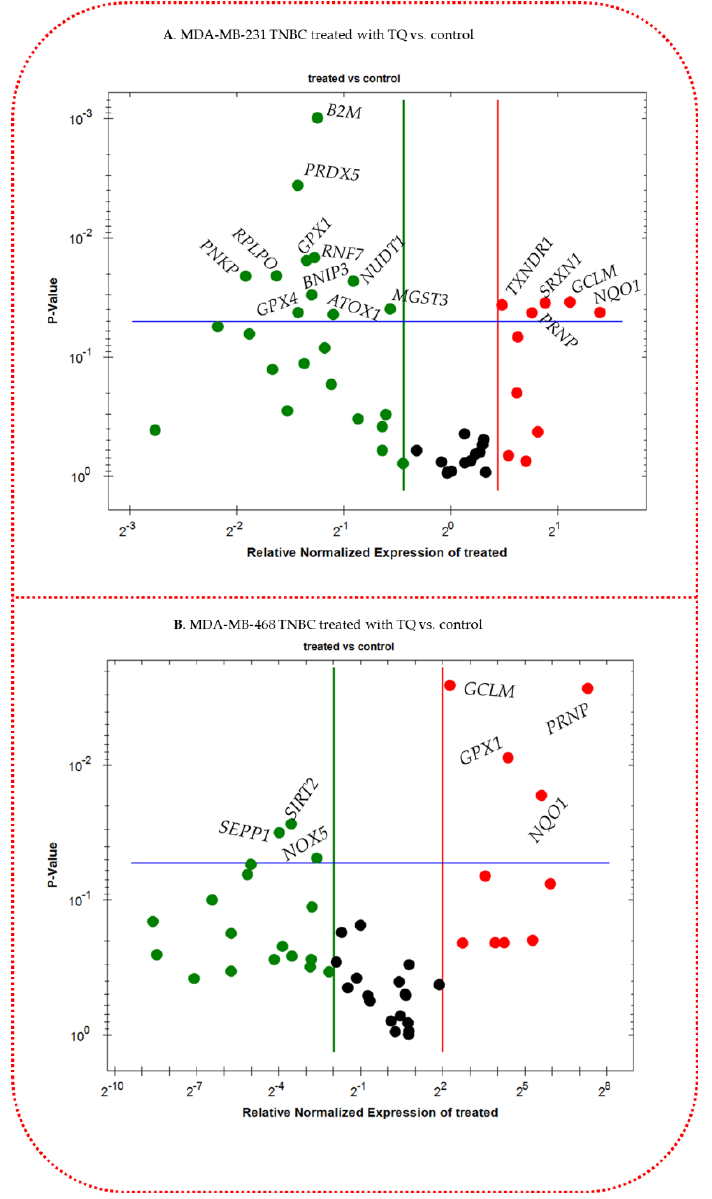
Figure 7. TQ altered oxidative stress − antioxidant defense-related gene expression in TNBC cells. After a 24 h treatment period with 15 µM in MDA − MB-231 cells ( A ), 5 and 11 genes were upregulated and downregulated, respectively, while in MDA − MB-468 cells ( B ) four and three genes were upregulated and downregulated, respectively. A volcano plot was used to categorize and display increased(red), repressed (green), or unaltered (black) mRNA gene expression. GPX1 : glutathione peroxidase 1, GPX4 : glutathione peroxidase 4 GCLM : glutamate − cysteine ligase, modifier subunit, NQO1 : NAD(P)H dehydrogenase, quinone 1, PRNP : prion protein, SIRT2 : sirtuin 2, NOX5 : NADPH oxidase, EF − hand calcium binding domain 5, TXNRD1 : thioredoxin reductase 1, SEPP1 : selenoprotein P, plasma, 1, PRDX5 : peroxiredoxin 5, B2M : beta − 2 − microglobulin, RPLPO : ribosomal protein, large, P0, PNKP : polynucleotide kinase 3′ − phosphatase, RNF7 : ring finger protein 7, BNIP3 : BCL2/adenovirus E1B 19 kDa interacting protein 3, NUDT1 : nudix (nucleoside diphosphate linked moiety X) − type motif 1, ATOX1 : antioxidant protein 1 homolog (yeast), MGST3 :